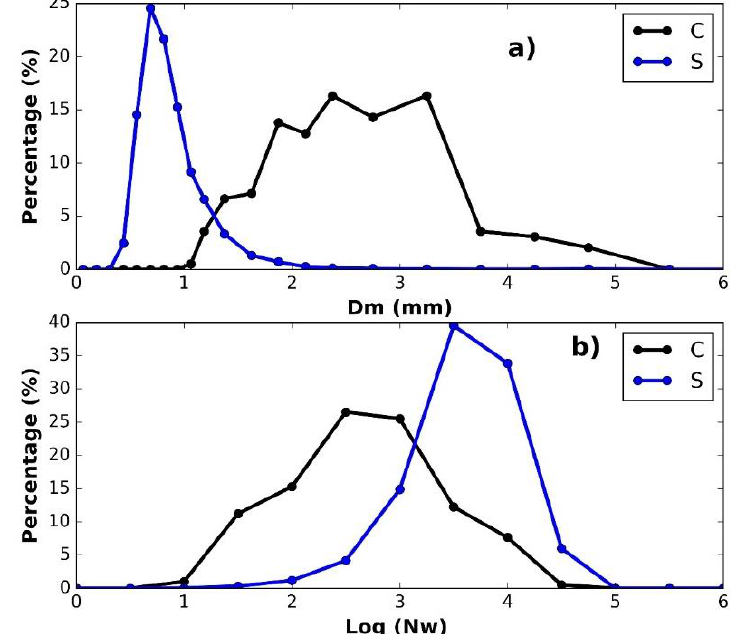
Figure 8. Occurrence percentage of the normalized parameters of the RSD determinate for two types of rainfall; S: stratiform and C: convective ( a ) Parameter Dm and ( b ) Log(Nw).